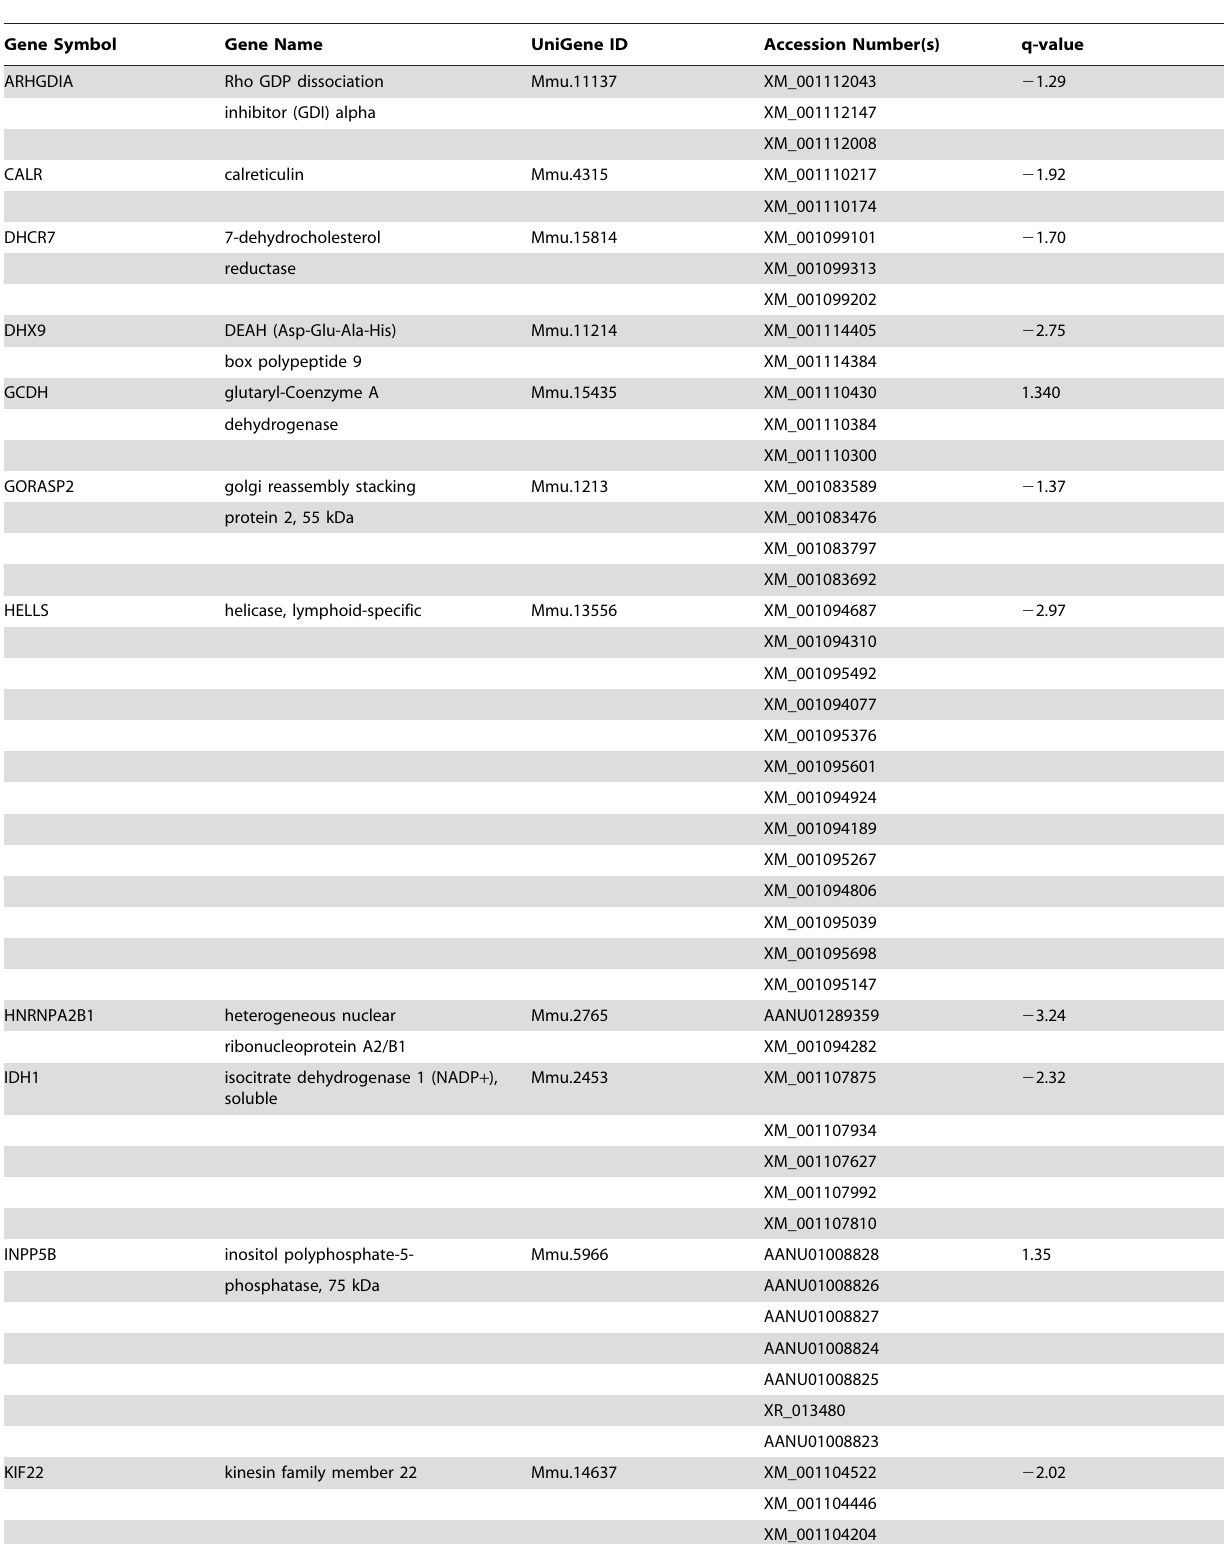
Table 6. Genes displaying differential expression between rhesus ESC generated from in vivo derived or in vitro cultured embryos and altered by oxygen in in vitro cultured preimplantation mouse embryos